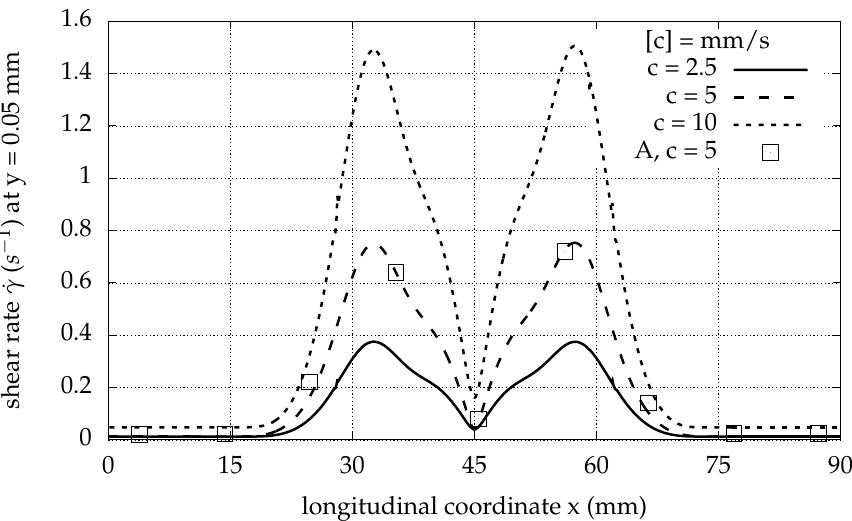
Figure 5. Shear rate near the central axis of the pump ( y = 0.05 mm) for various values of c and for RO = 0.6, n = 1 and one roller. Comparison with existing results (A: Data from [12]) is presented.